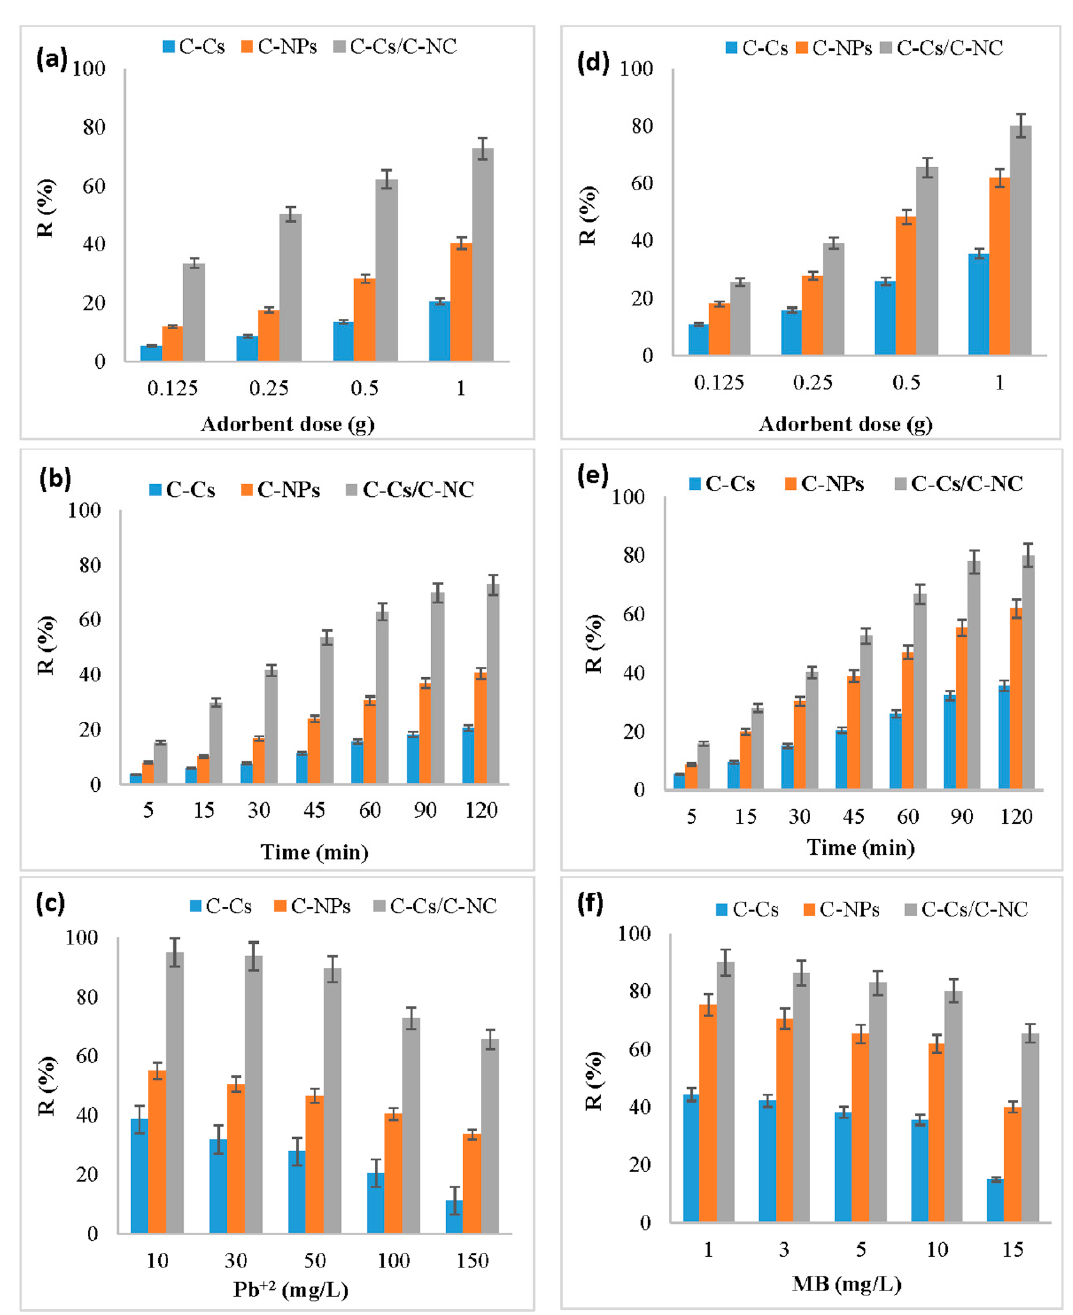
Figure 6. Effect of concentration, contact time, and adsorbent dose on removal percentage for Pb +2 ( a – c , respectively) as well as MB ( d – f , respectively).